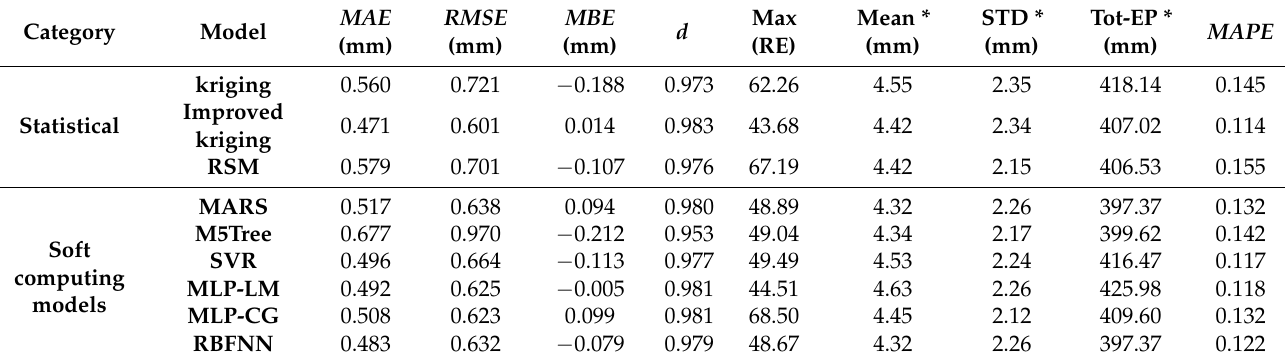
* The mean, standard deviation (STD) and total pan evaporation (Tot-EP) of the actual test data points are mean= 4.532 mm, STD = 2.295 mm and Tot-EP = 416.9 mm, respectively. Optimal structure of SVR: (C = 1600, ε = 0.25, σ = 80), ANN(LM): 6-9-1, ANN(CG): 6-7-1, RBFNN: 6-30-1 ( σ = 15). Table 5. Comparison of statistical errors for the applied models with periodicity (scenario #2) for Antakya Station in the testing